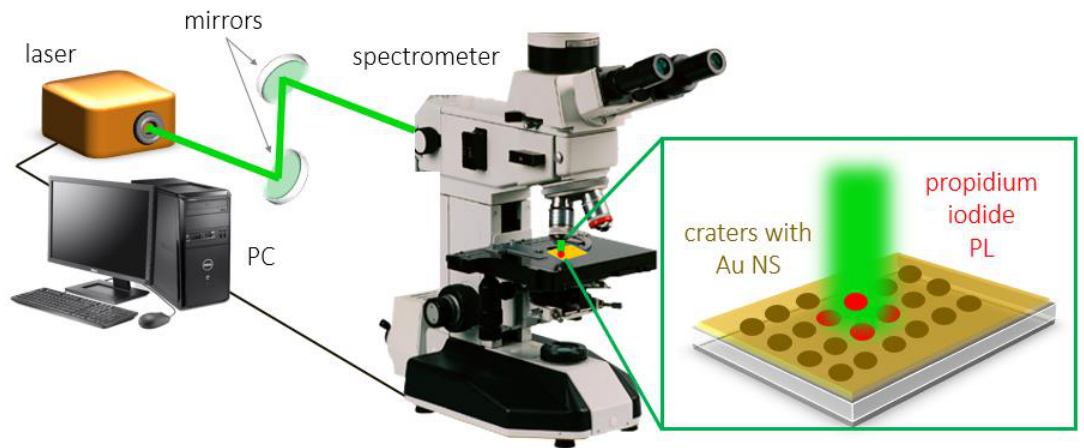
Figure 2. Schematic view of propidium iodide luminescence measurement on Au nanospikes. The resulting signal was acquired from an area of one microcrater.